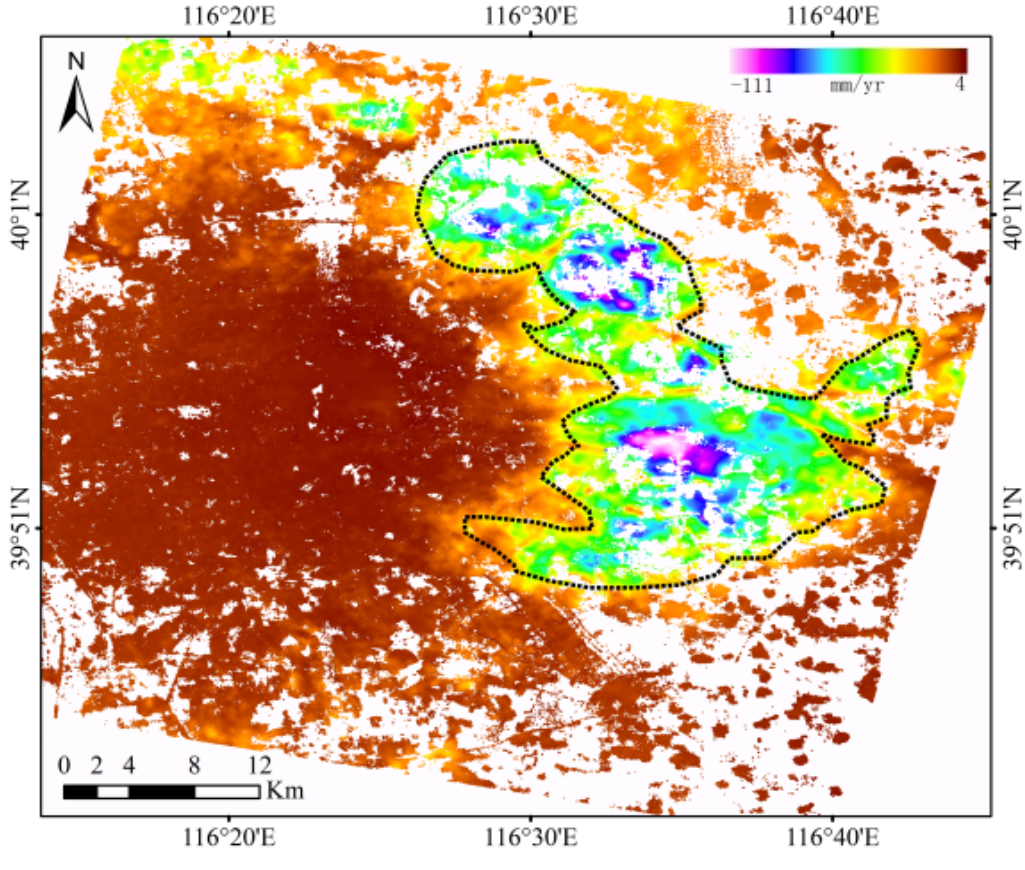
Figure 10. Average displacement velocity map from June 2003 to August 2010. The black broken line delineates the groundwater depression cone